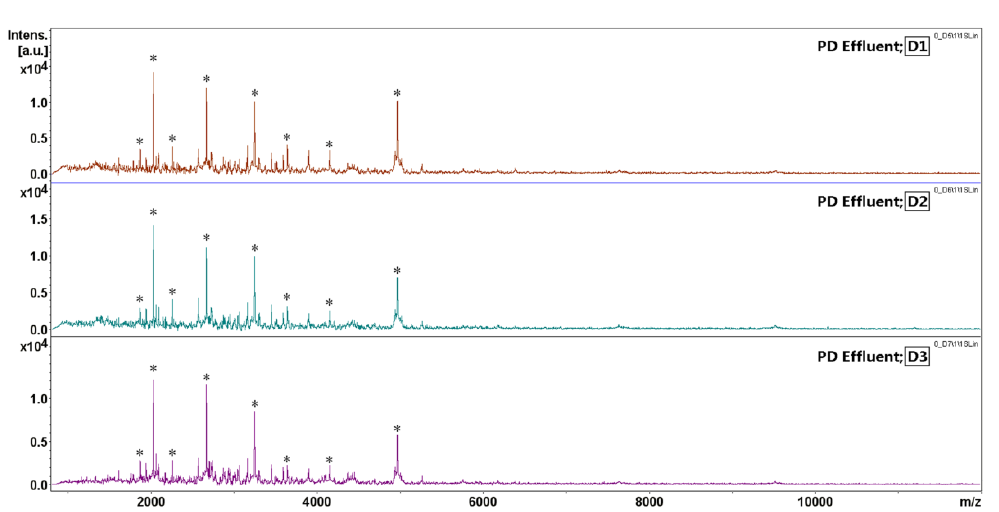
The intra-day reproducibility study for matrix-assisted